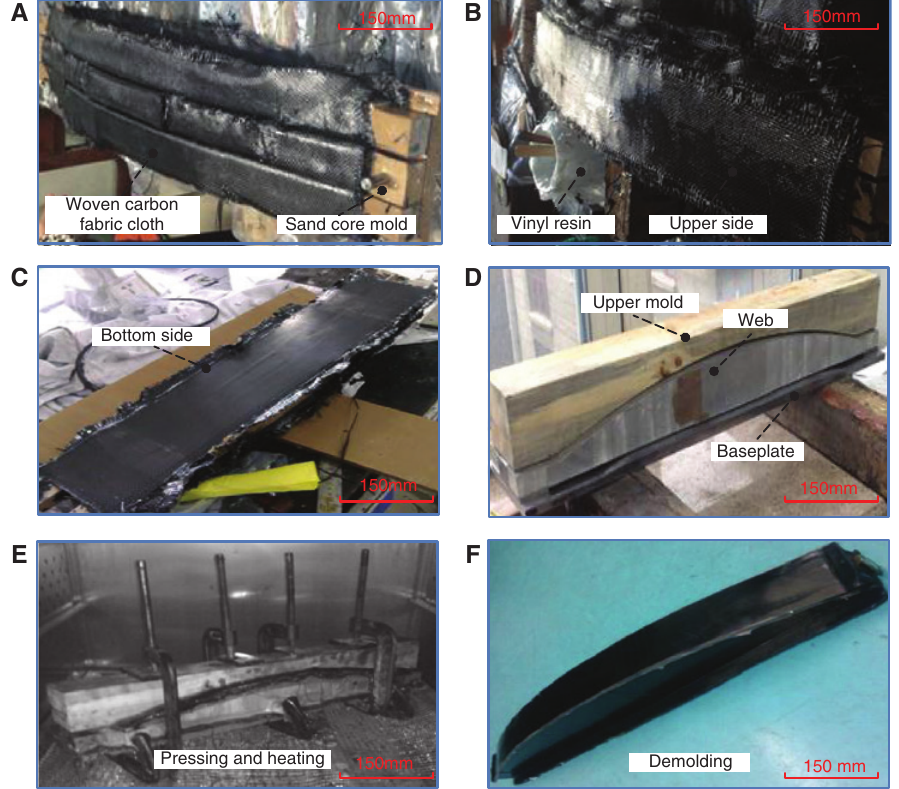
Figure 9: Manufacturing process of box girder by mold-pressing prepreg technology.